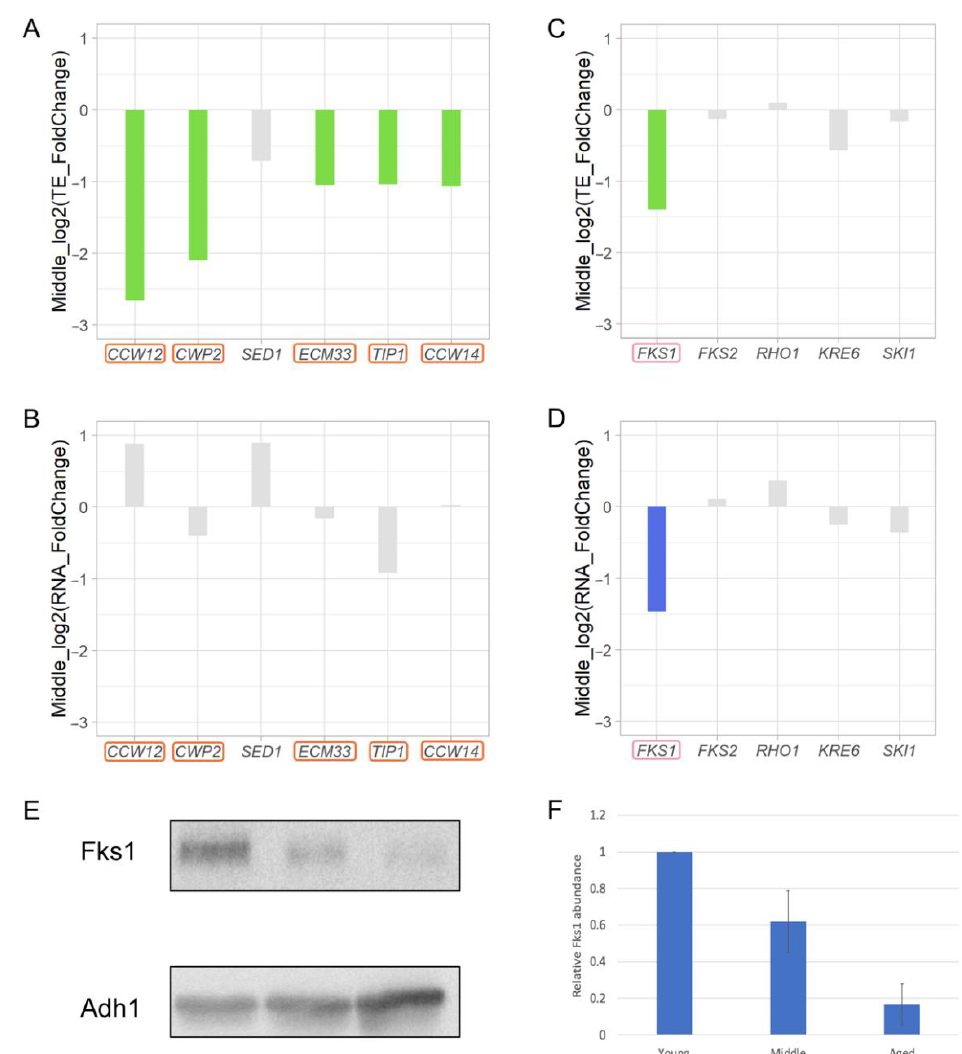
Figure 7. Translation of genes involved in cell wall synthesis decreases. Changes in translational efficiency ( A ) and RNA ( B ) of genes encoding major mannoprotein components and changes in translational efficiency ( C ) and RNA ( D ) of genes involved in cell wall synthesis in Middle cells are shown. Green indicates downregulation of translational efficiency by more than twofold. Blue indicates downregulation of RNA by more than twofold. Grey indicates no notable changes. Genes with decreased translational efficiency more than two-fold are indicated by the red box. Young cells were used as a control. ( E ) Western blotting analysis of Fks1 protein in Young, Middle, and Aged cells. Adh1 served as a loading control. ( F ) Relative quantitative Fks1 protein level of the Western blotting results. Young is shown as 100%. The means and standard errors of 6 experimental replicates of 2 biological replicates are shown.